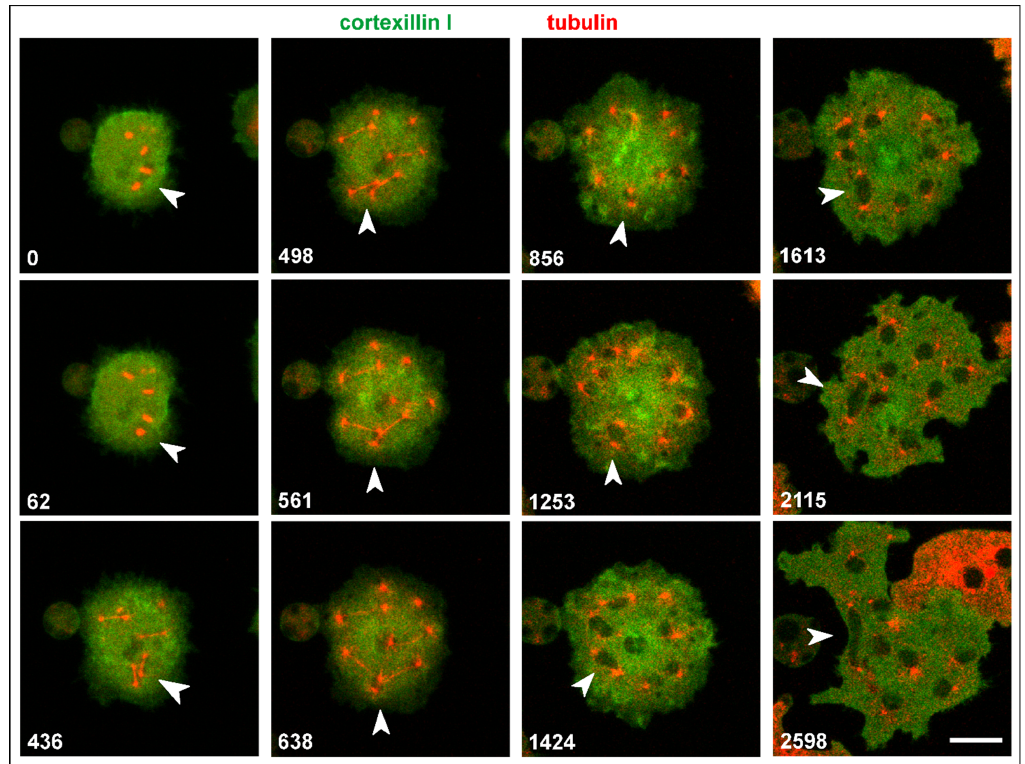
Figure 8. Two adjacent spindles join to form a bicentric nucleus. During mitosis of a multinucleate Septase-null cell, one pole of each of two spindles associated with the same daughter nucleus (arrowheads). The Septase-null cell expressed GFP-cortexillin I (green) and RFP- α -tubulin to label the mitotic apparatus (red), which leaves the nuclei unstained. After